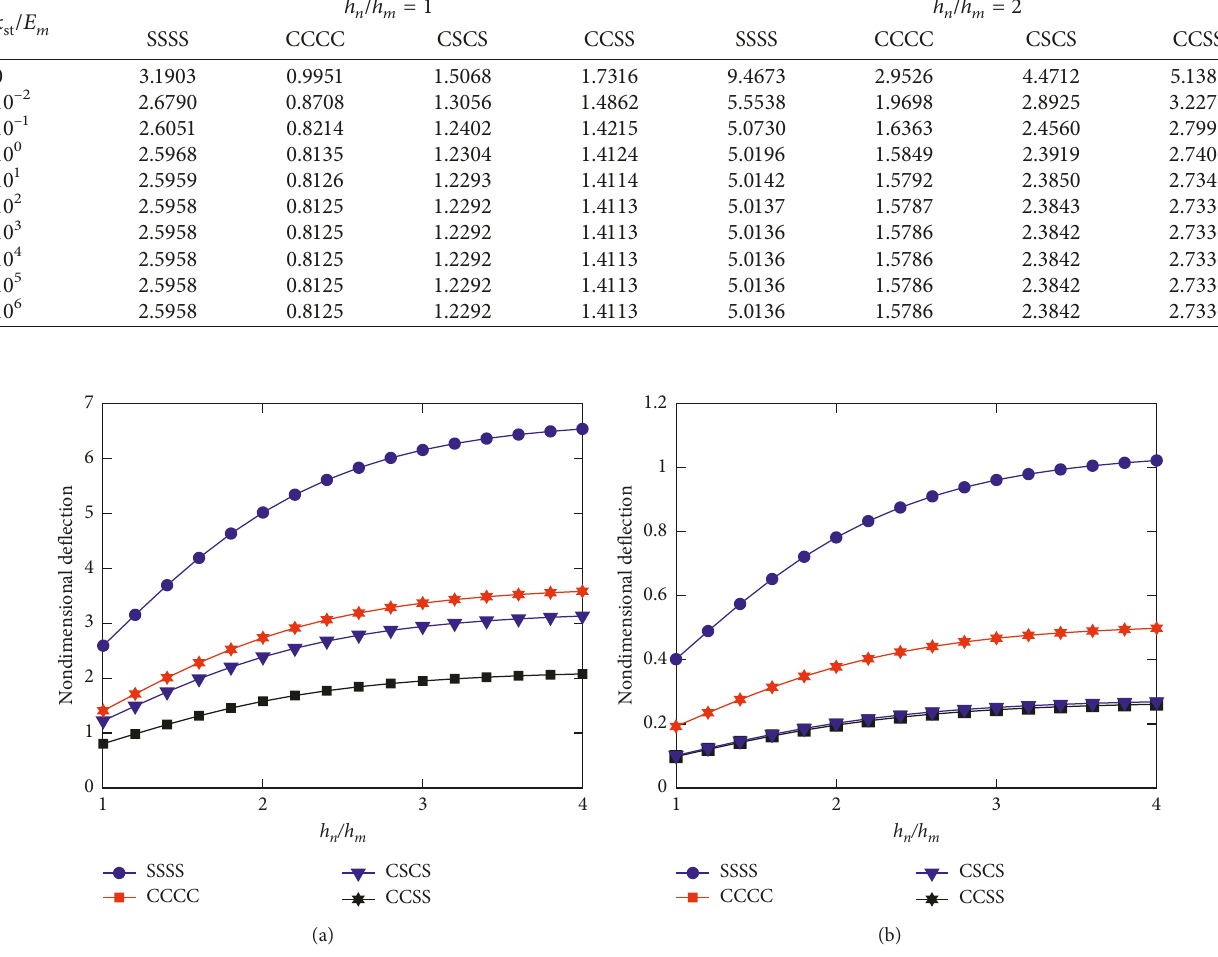
Figure 5: The effect of ratio h